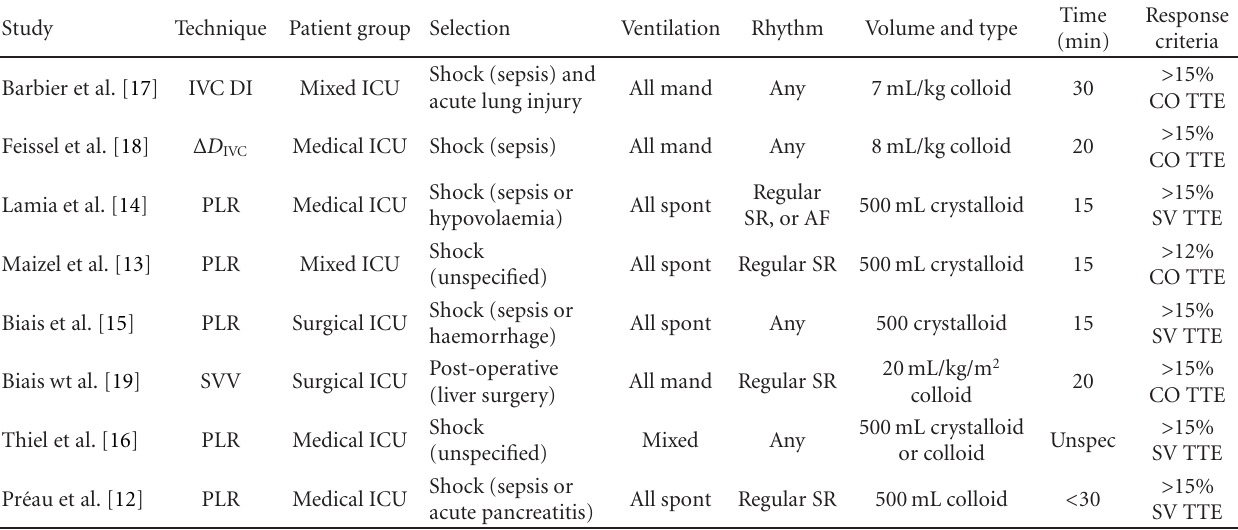
Table 2: Characteristics of studies selected.